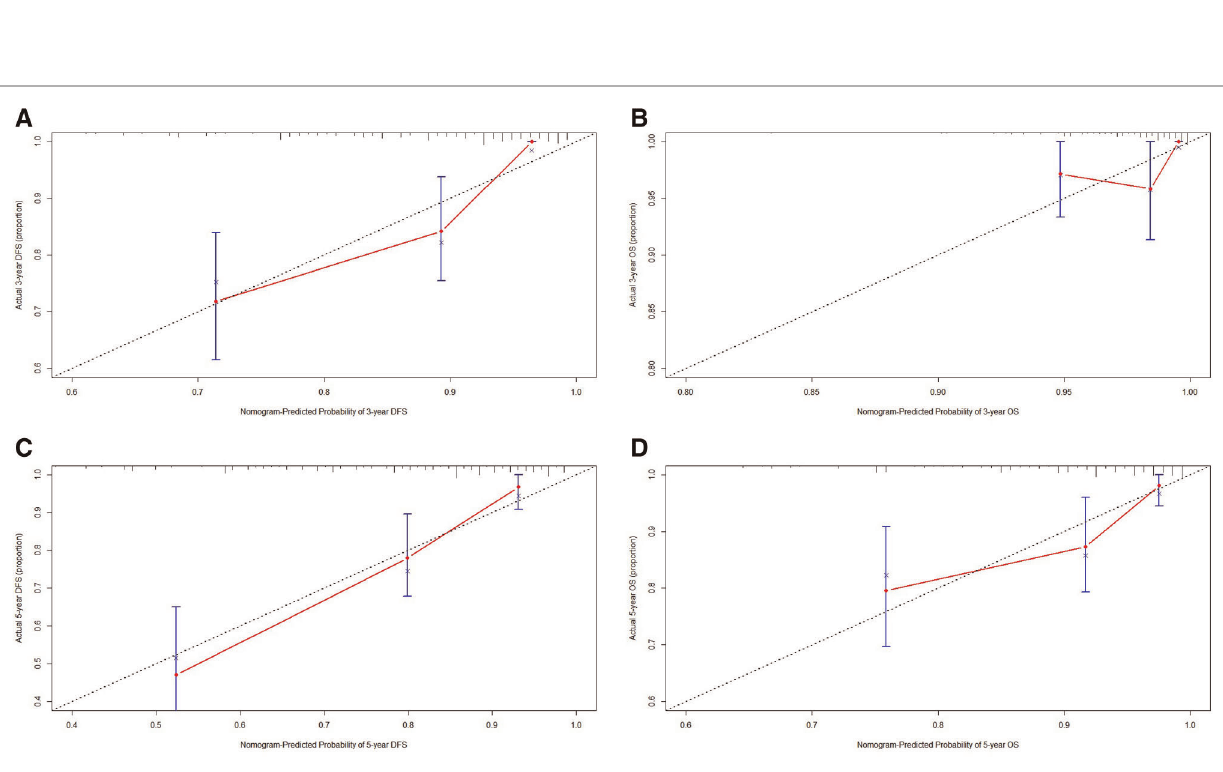
Frontiers in Surgery |